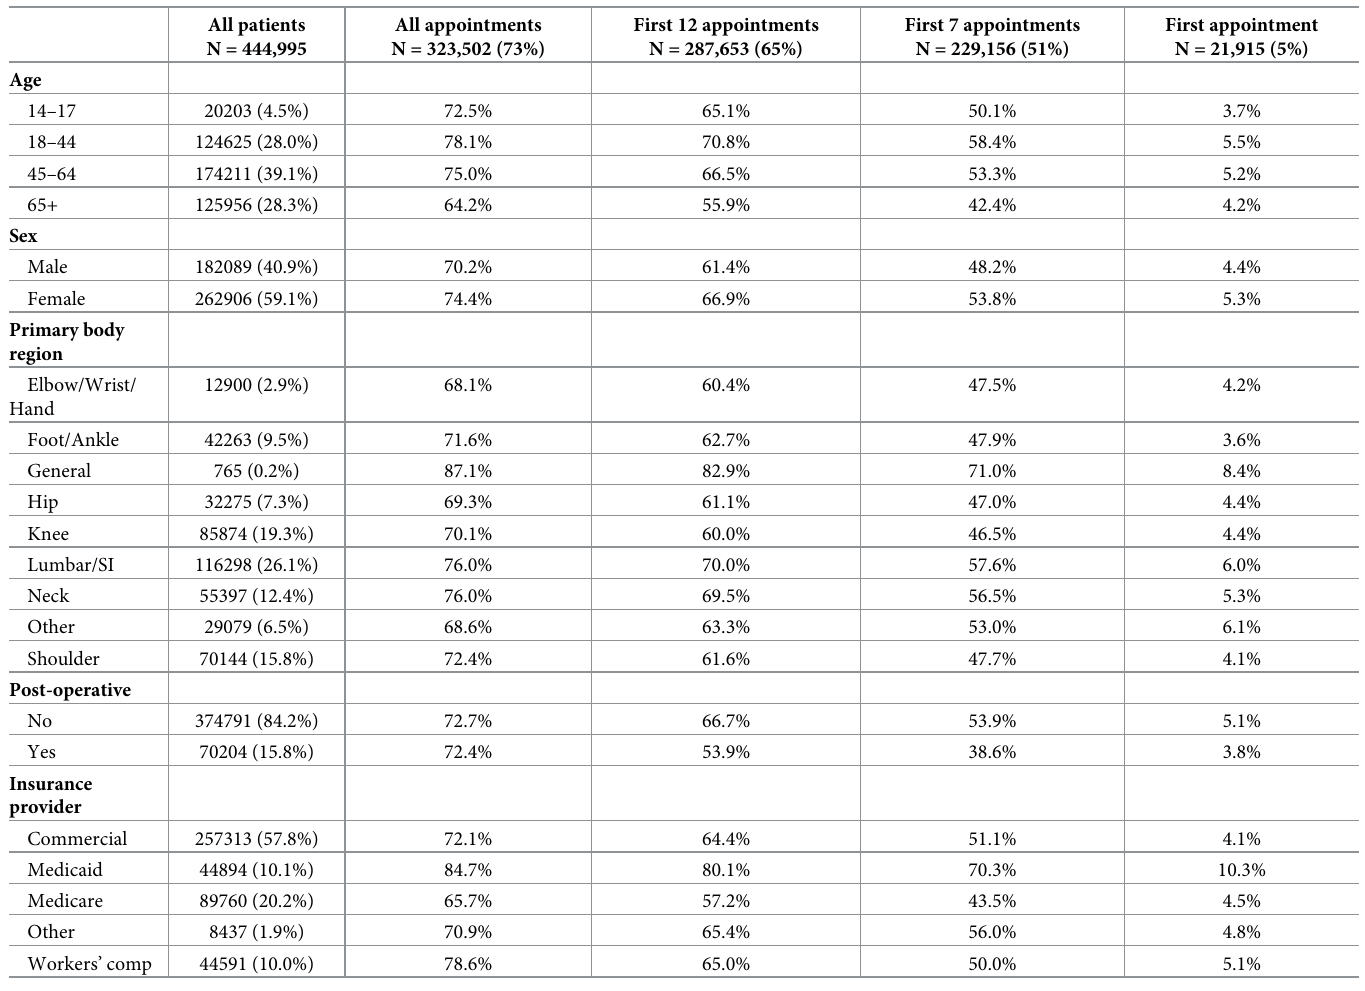
Table 2. Prevalence of no-shows within 1, 7, 12, and all